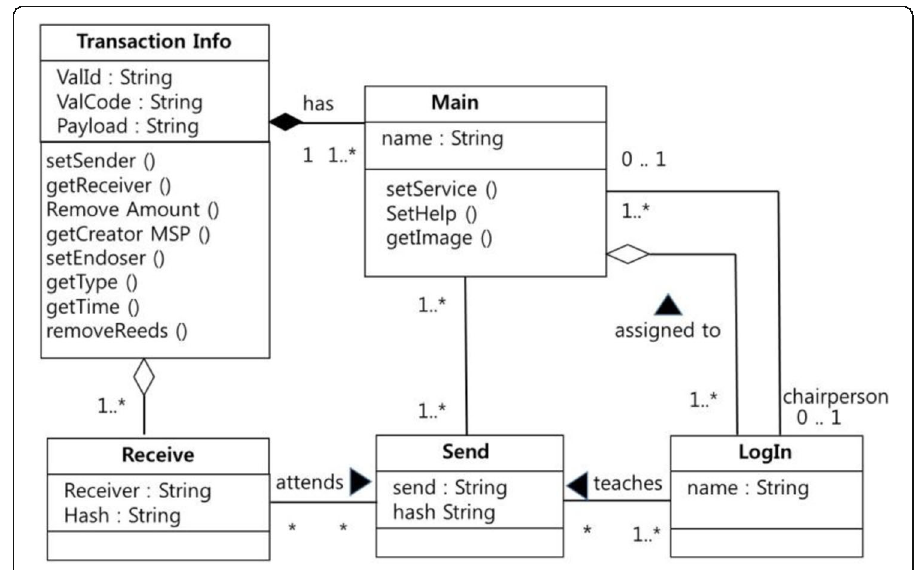
Fig. 13 UML diagram of House Rental dApp Image Application